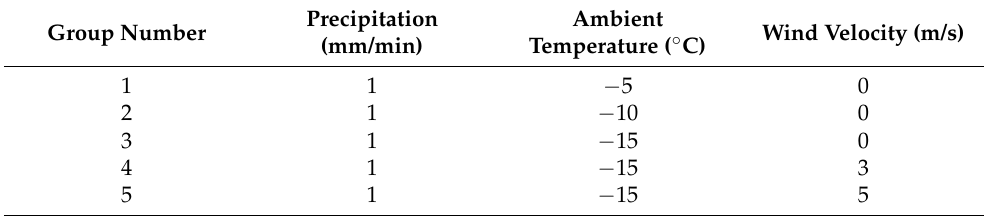
Table 2. The test conditions of icing tests.